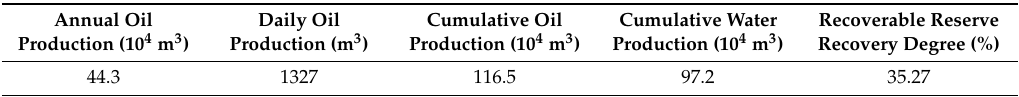
Table 1. Development status of Daqing oilfield in 2016.